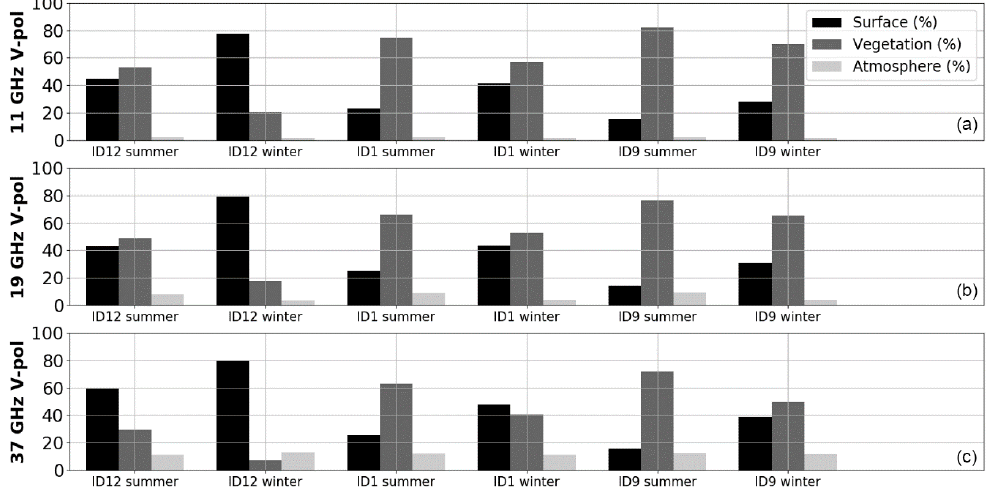
Figure 9. Percentage of surface (black), vegetation (dark gray), and atmosphere (light gray) contributions to the simulated PMW signal at the top of the atmosphere (before DA) at the three frequencies 11 (a) , 19 (b) , and 37GHz (c) . ID12, ID1, and ID9 are Site 12 ( f cover of 24.2%), 1 ( f cover of 63.7%), and 9 ( f cover of 84.0%), respectively (see Table 2). Summer and winter periods are defined as periods when snowpack is observed or